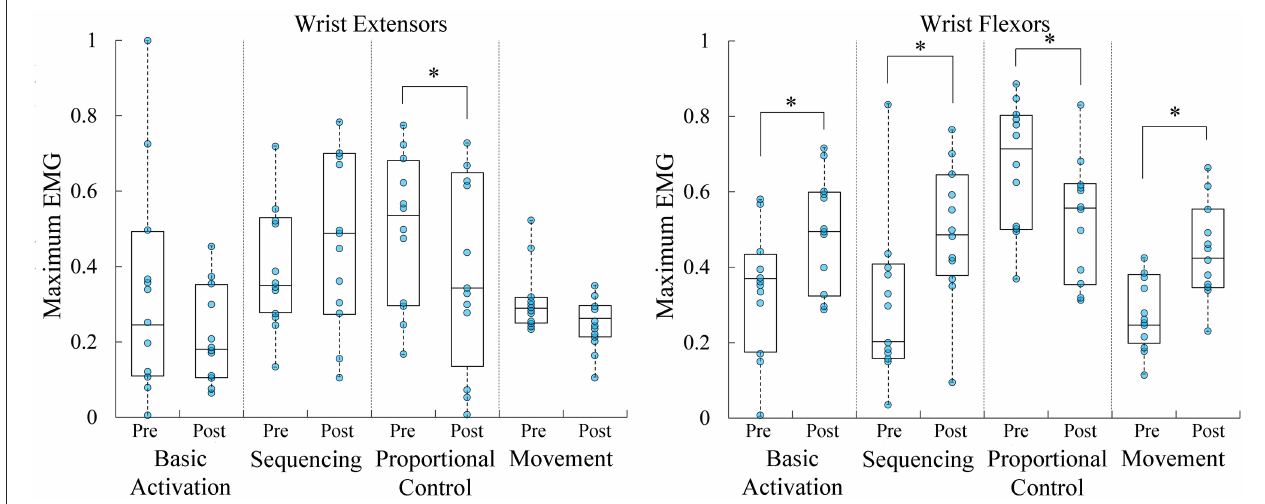
FIGURE 7 | Boxplots overlaid with raw data of maximal rectified EMG, shown at left for wrist extensors and at right for wrist flexors, across the 4 types of training. Wrist flexor maximum EMG increased for basic activation, sequencing, and movement skills. Wrist flexor and extensor maximal EMG decreased during proportional control and isolation. * p <